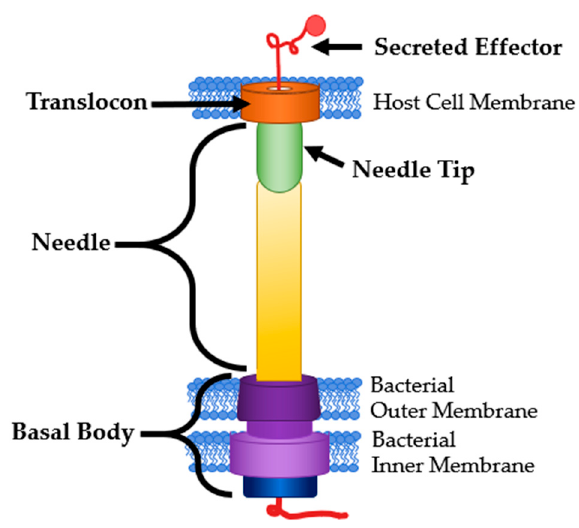
Figure 1. T3SS Structure and Common Targets. Modified from [3].